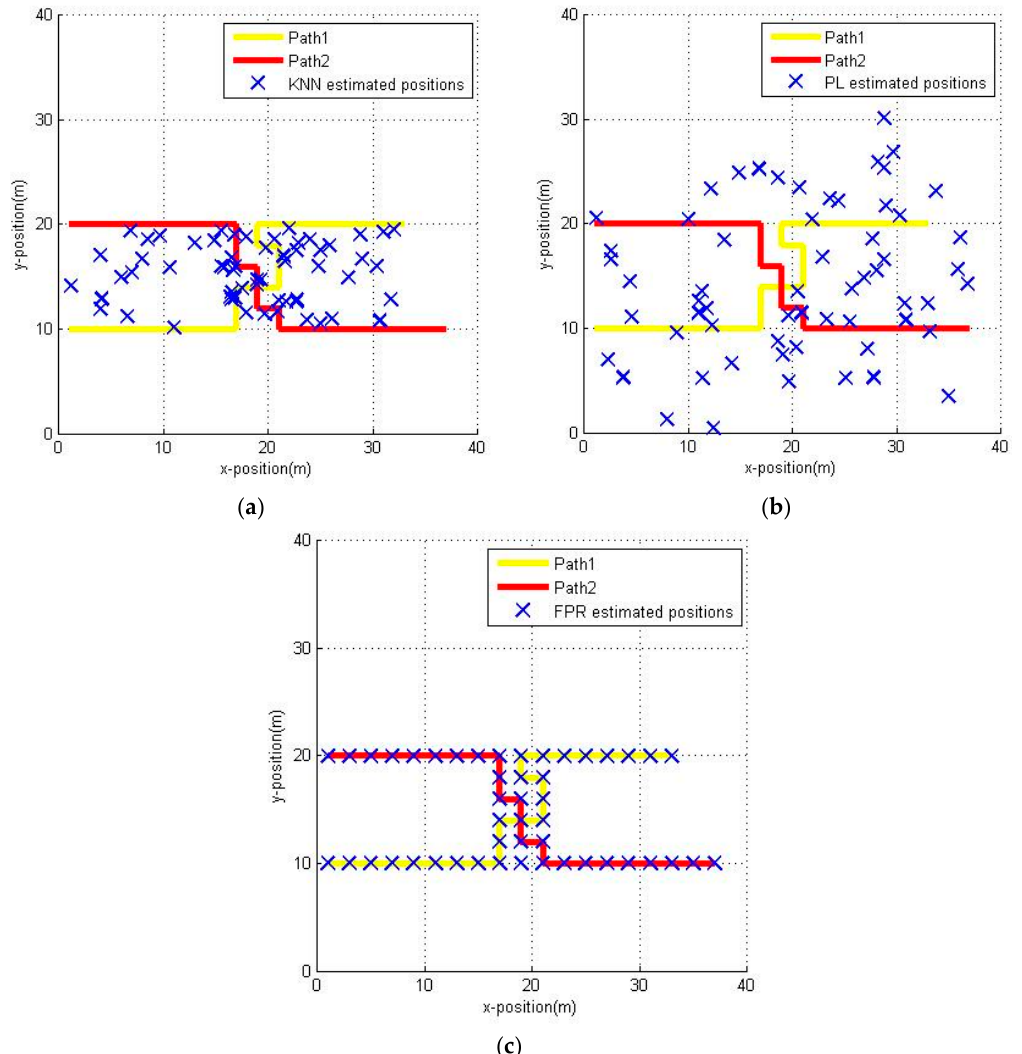
Figure 9. Estimated positions by different positioning algorithms: ( a ) KNN algorithm; ( b ) PL algorithm; ( c ) FPR algorithm.